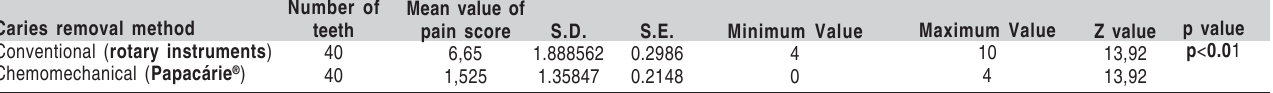
Table 2 - Mean value of pain scores for the chemomechanical and conventional methods of caries removal